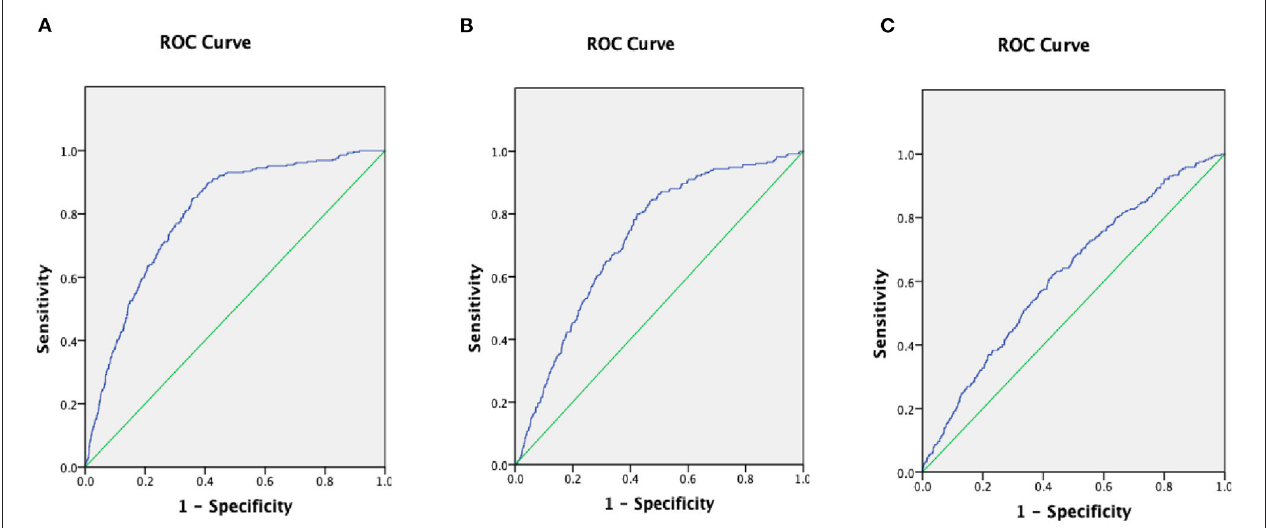
FIGURE 4 | The areas under the curves (AUC) of AUC of ALB-dNLR + classic risk model (A) , the AUC of dNLR + classic risk model (B) , and he AUC of ALB + classic risk model (C) in CAD patients. ALB, albumin; dNLR, derived neutrophil to lymphocyte ratio.